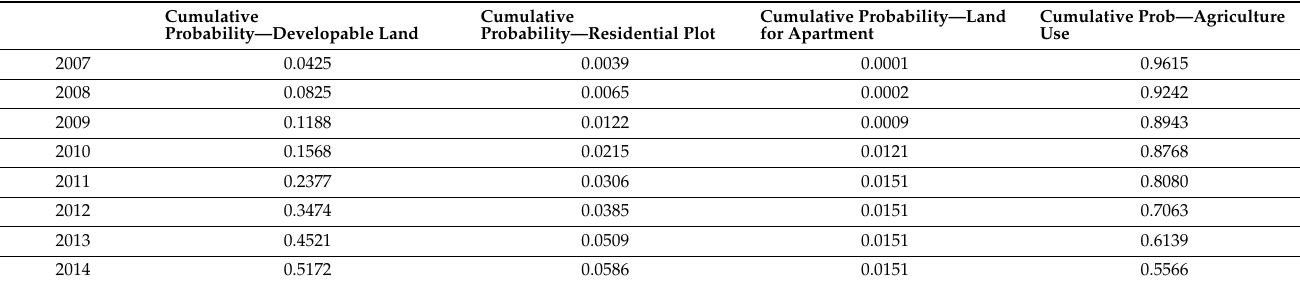
Table 4. Cumulative probabilities of land use conversion.